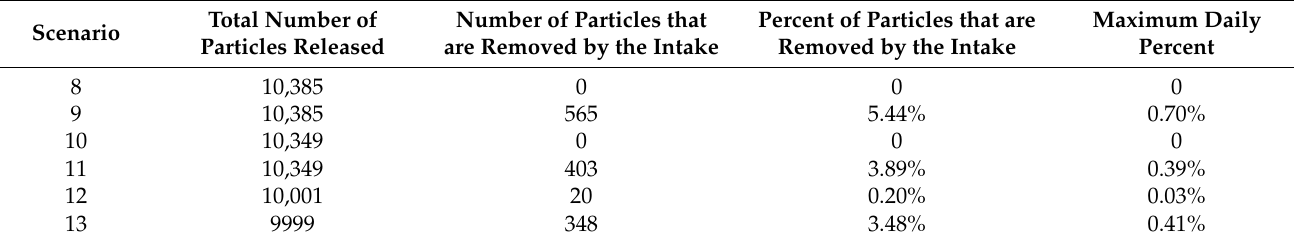
Table 4. Summary of the forward particle tracking scenarios 8–13, considering the impact of flow conditions. Kruskal–Wallis test shows that the difference between the scenarios is significant ( p -value < 10 − 6